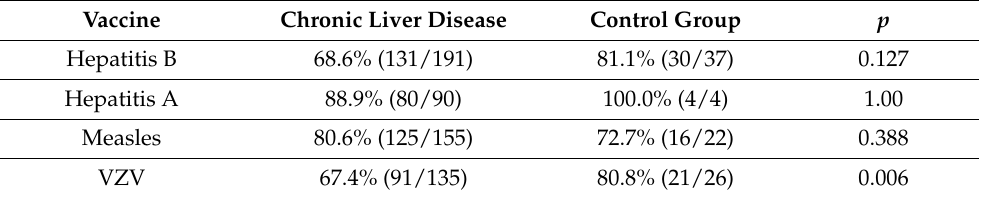
Table 5. Prevalence of seropositive rates of IgG antibodies before transplantation in age-appropriate vaccinated infants. Data is expressed as percentage of protective titers (number of age-appropriate vaccinated children with protective titer/total number of investigated children with available titer prior to